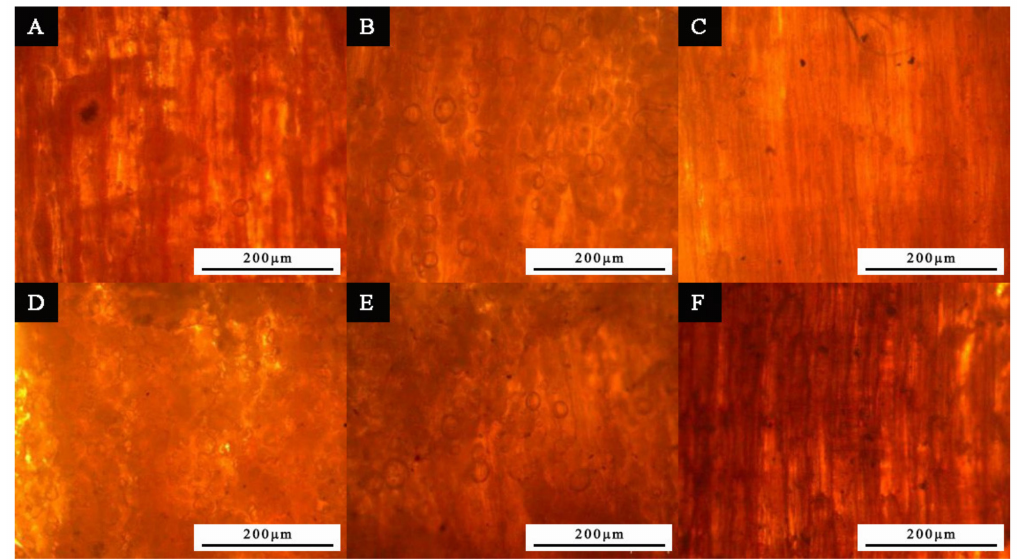
Figure 5. Microstructure of paint film with different contents of urea formaldehyde resin-coated nano-silver solution microcapsules: ( A ) 1.0%, ( B ) 4.0%, ( C ) 7.0%, ( D ) 10.0%, ( E ) 13.0%, and ( F ) 16.0%.